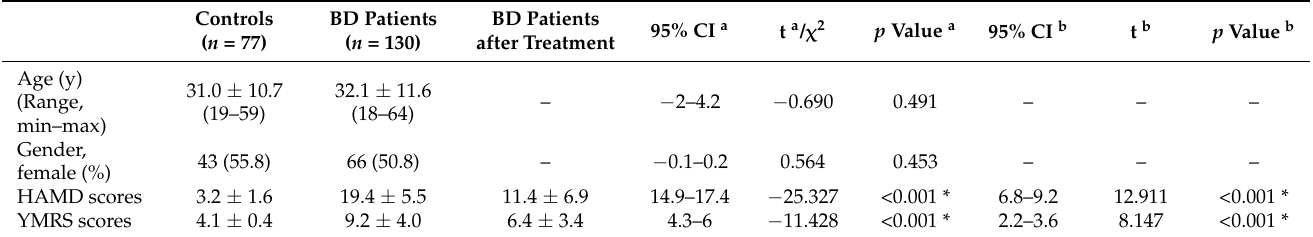
Table 1. Demographic characteristics and measurements between controls and BD patients.